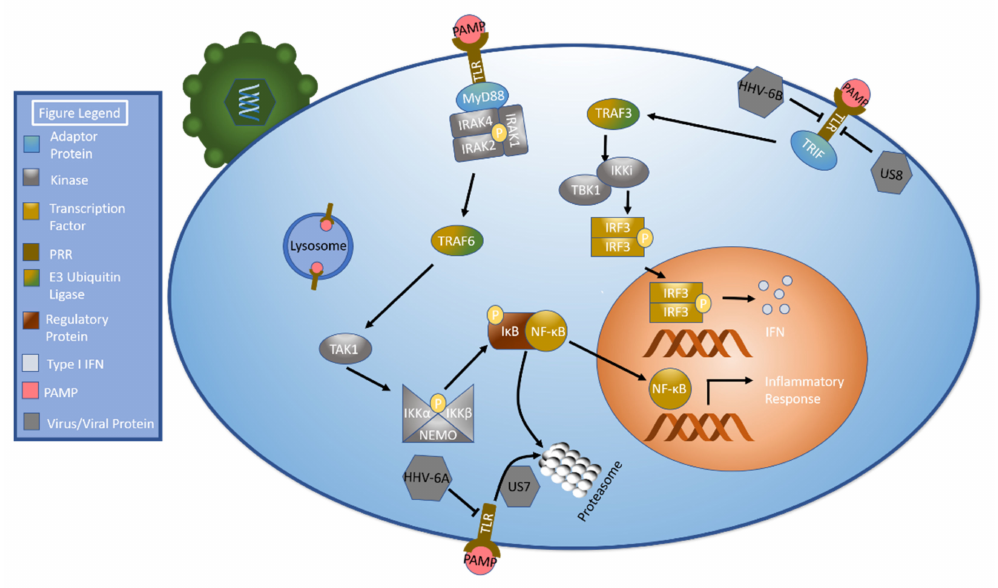
Figure 3. Toll-Like Receptor (TLR) Signaling and Inhibition. The TLR signaling pathway begins after a pathogen-associated molecular pattern (PAMP) binds to the TLR. There are two main signaling pathways activated by TLRs. TLR activation through MyD88 results in the formation of a myddosome, which includes MyD88, IRAK1, IRAK2, and IRAK4. The myddosome then activates TRAF6, which activates TAK1. TAK1 phosphorylates the IKK complex, which in turn phosphorylates I κ B. I κ B phosphorylation triggers its proteasomal degradation and the subsequent release of the transcription factor NF- κ B. The second pathway involves TRIF associating with the TLR. TRIF activates TRAF3, which activates TBK1 and IKKi. These phosphorylate IRF3. As in the STING pathway, IRF3 dimerizes and translocates to the nucleus to induce an interferon response. The HCMV protein US7 inhibits signaling by targeting TLR3 and TLR4 for proteasomal degradation, while the HCMV protein US8 inhibits signaling by destabilizing TLR3 and TLR4. Of note, HHV-6A and HHV-6B have been shown to downregulate TLR9 protein